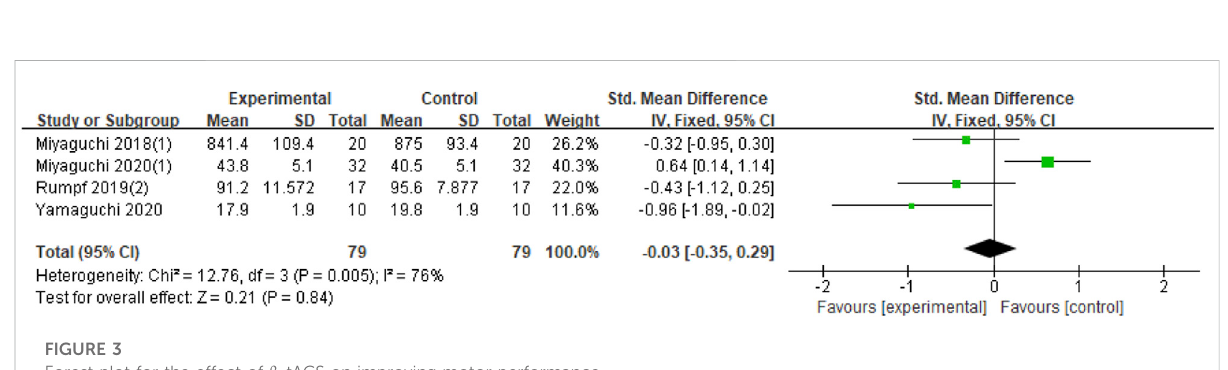
FIGURE 3 Forest plot for the effect of β -tACS on improving motor